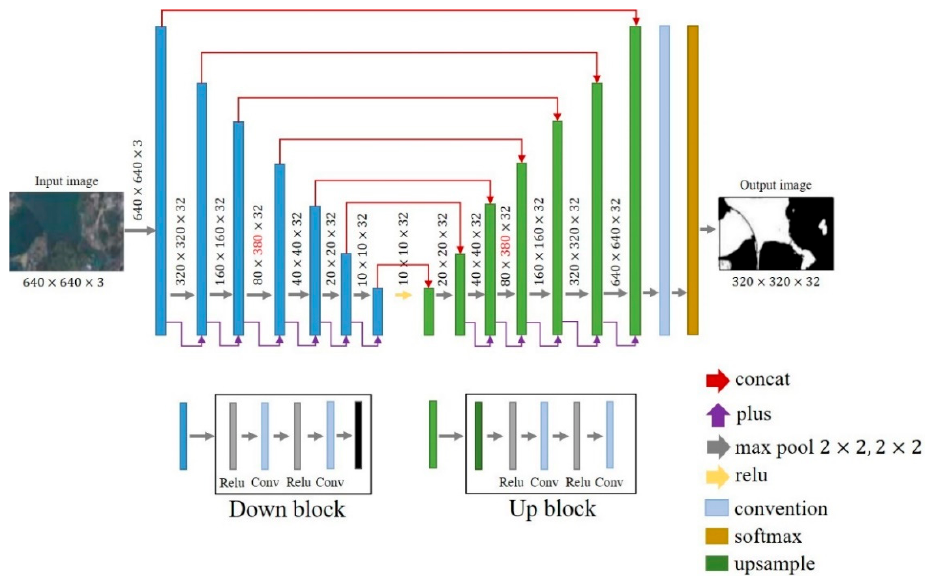
Figure 3. DeepUnet system architecture [8] .